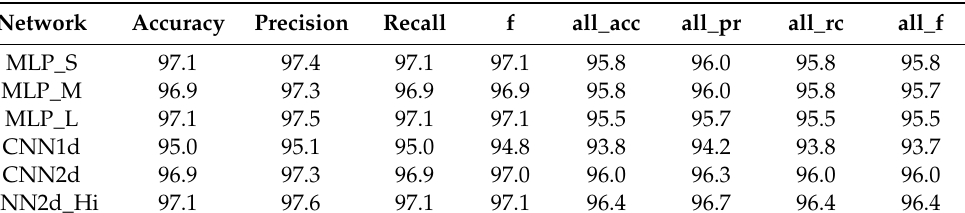
Table 9. Results of K-fold cross-validation with HQ.